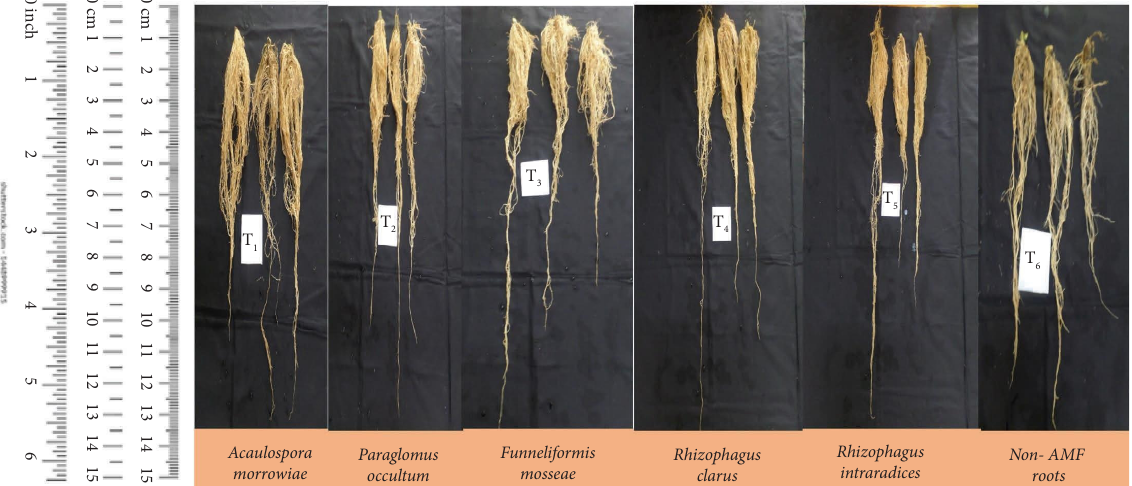
Figure 2: Mycorrhizal and non-mycorrhizal treated roots of tomato plants under drought